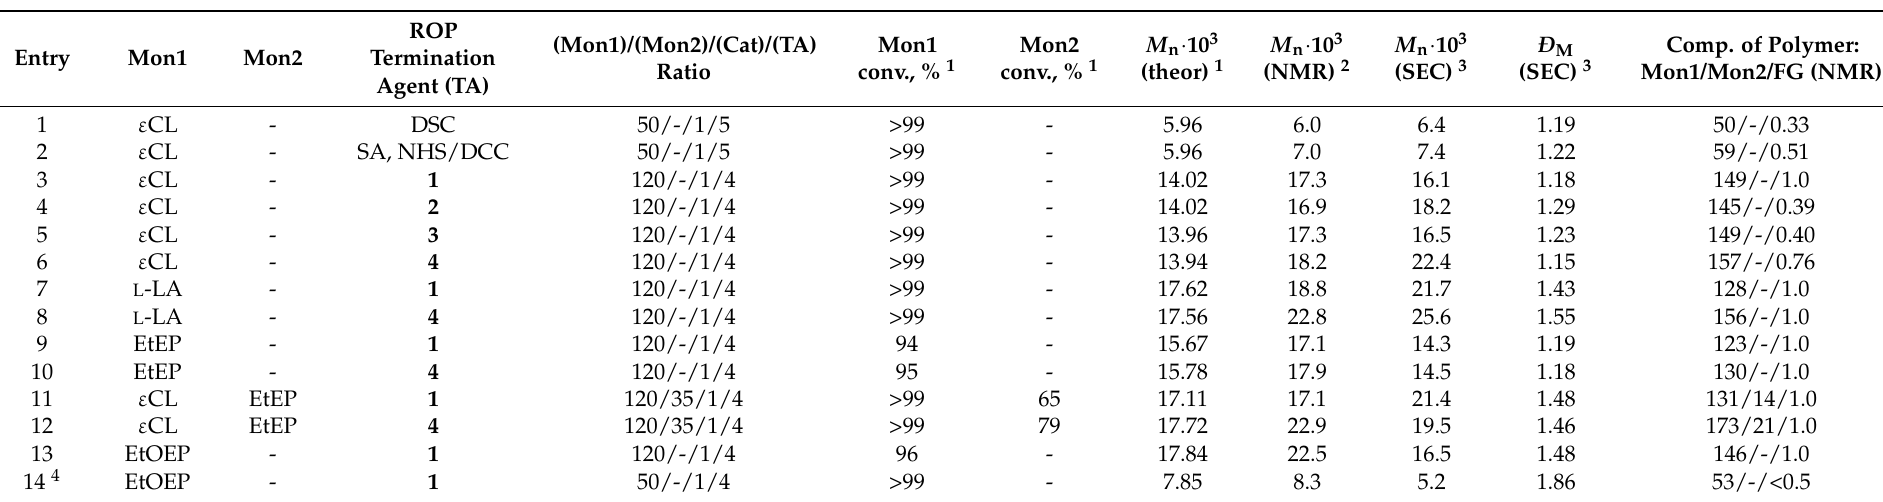
Table 1. Synthesis of NHS- and MI-functionalized polymers via termination of BHT-Mg catalyzed “living” ROP by DSC, SA and acyl chlorides 1 – 4